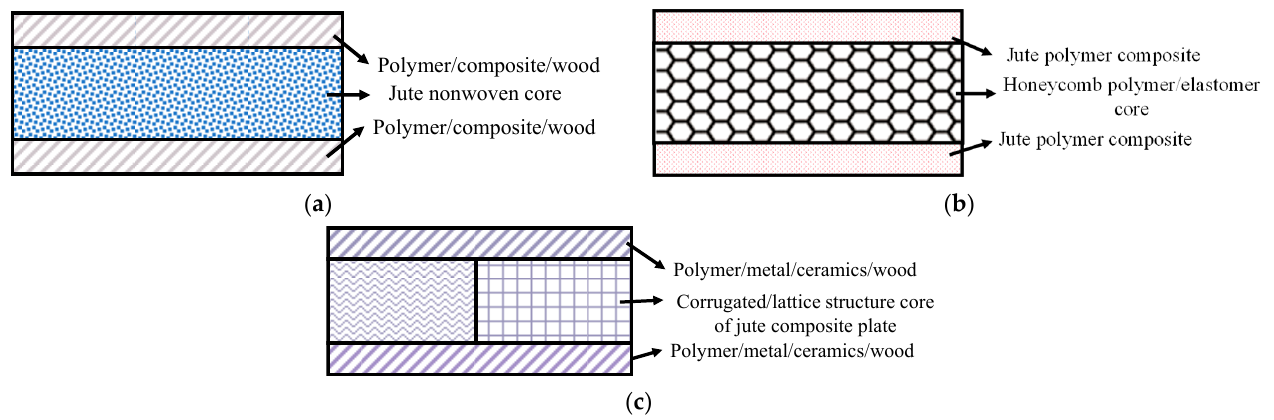
Figure 21. Some examples of sandwich type jute-based composite design ( a ) jute as core ( b ) jute composite as skin and ( c ) jute composite lattice/corrugated structure as the core.